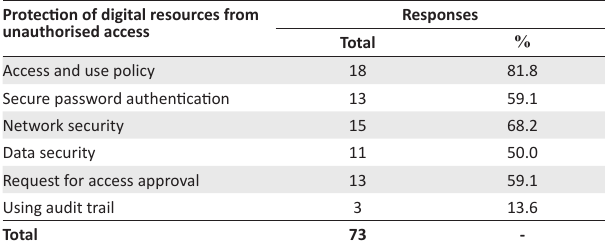
TABLE 5: Protection of digital resources from unauthorised users.